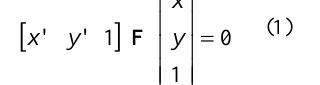
Figure 8. Visualisation of bundle adjustment results – the